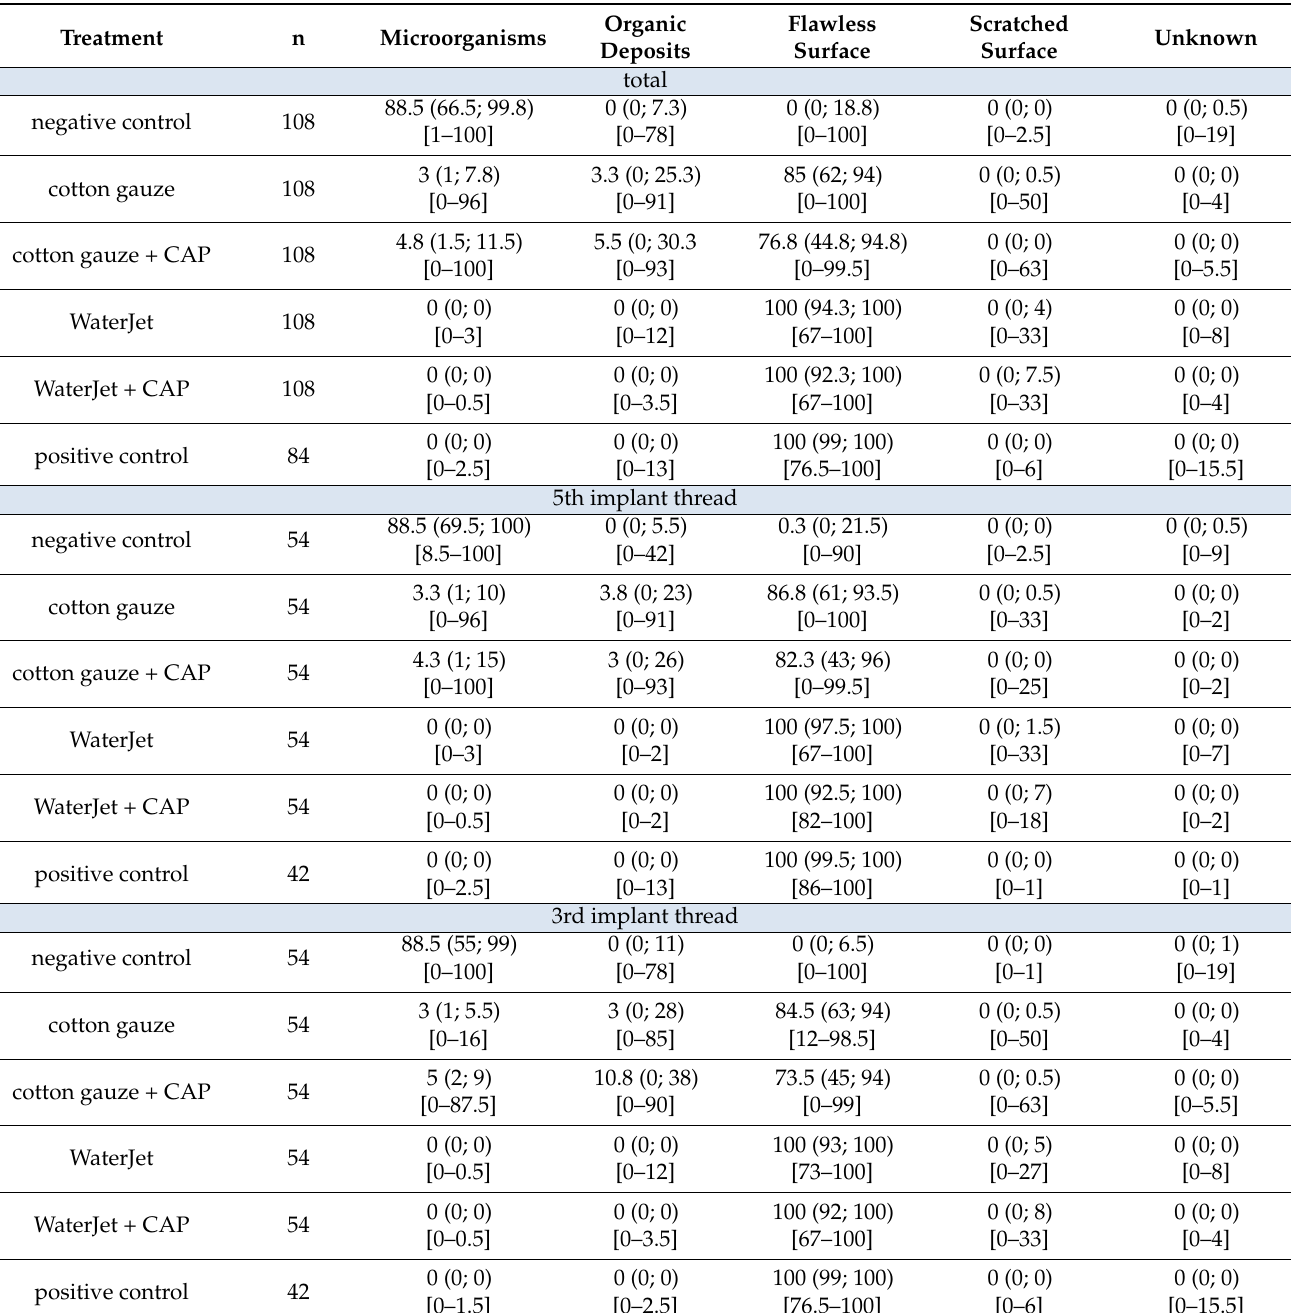
Table A3. Median percentages of cross points with microorganisms, organic deposits, flawless surface, scratched surface, and unknown by